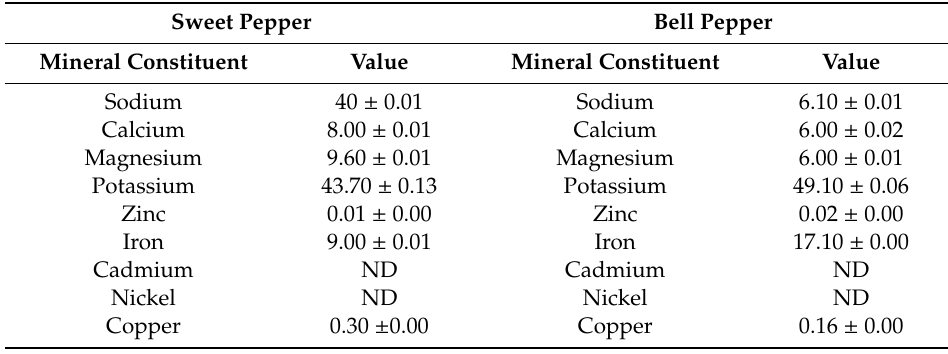
Table 2. The mineral constituents of oils extracted from two varieties of C. annuum (sweet and bell